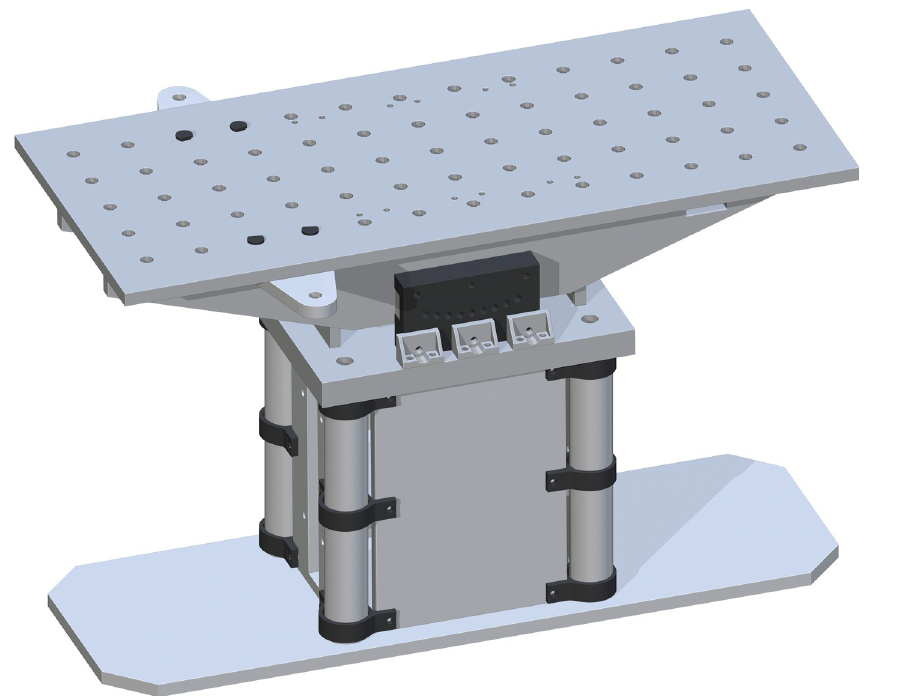
Fig 14. Addition of Arm Attachments to Table